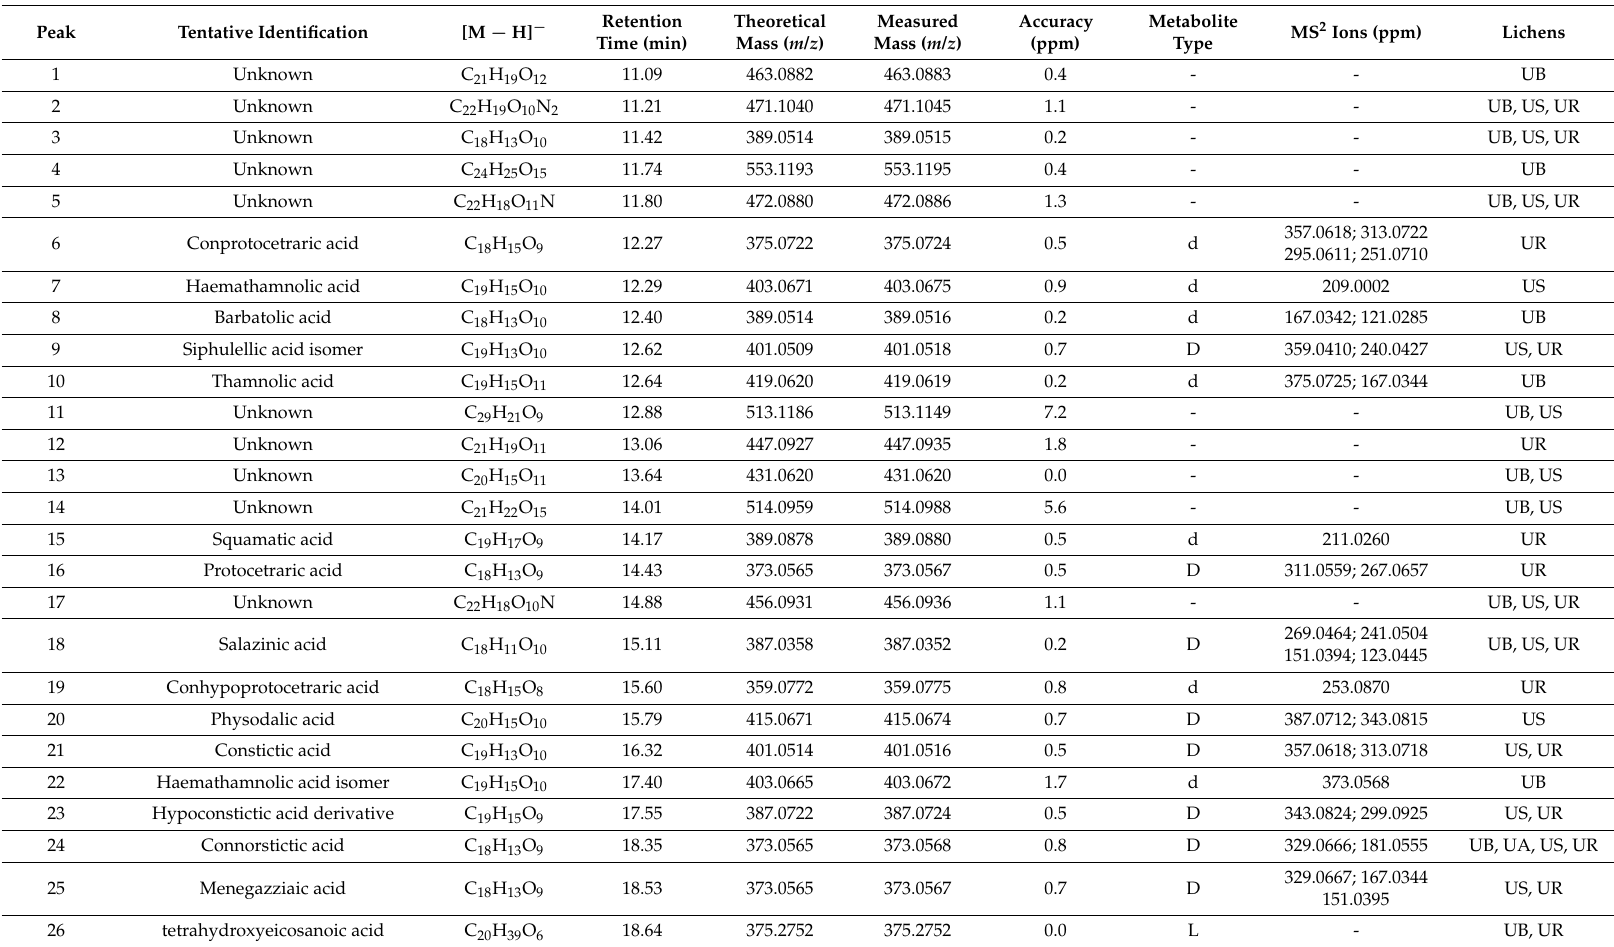
Table 1. Identification of metabolites in Usnea species by